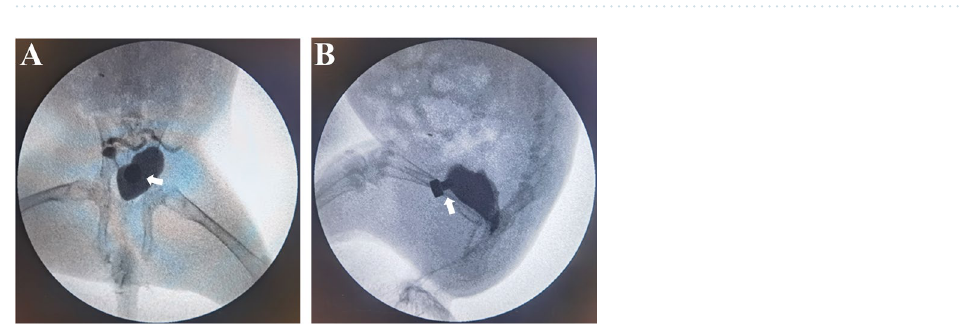
Figure 4. Confirmation of the position of the two magnets by cystography. ( A ) Anteroposterior radiograph; ( B ) Lateral